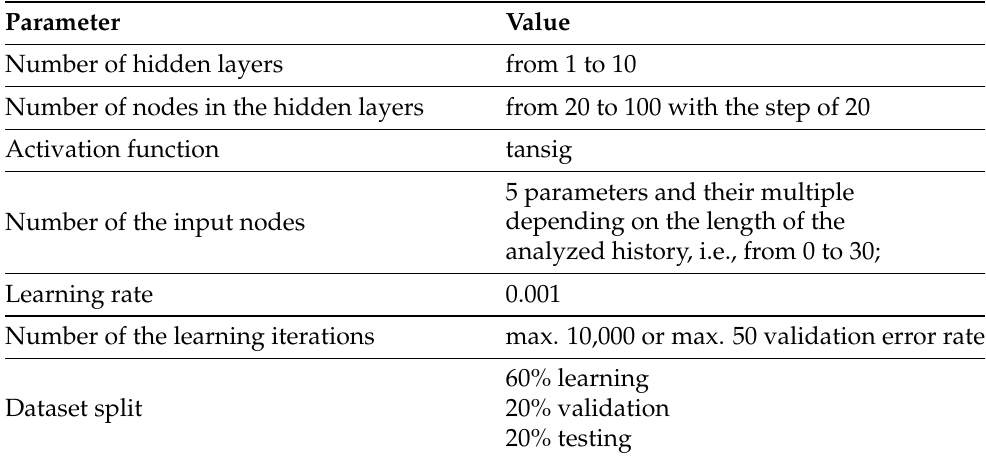
Table 6. The hyperparameter variability and the learning parameters in the second stage of the learning